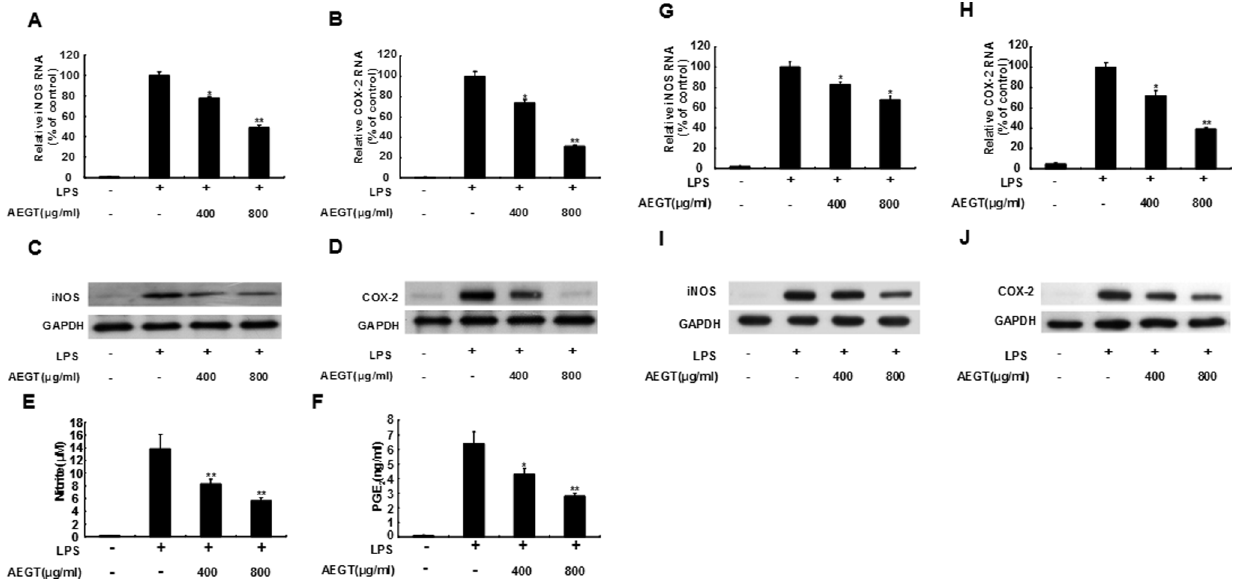
Figure 2. Effect of AEGT on NO/PGE 2 production and iNOS/COX-2 expression in LPS-stimulated RAW 264.7 cells (A–E) and primary rat peritoneal macrophages (G–J). Cells were seeded in a 24-well plate, treated with 400 or 800 m g/ml AEGT for 1 h, and then incubated with 1 m g/ml LPS for 24 h. The cell lysates were collected to determine the RNA (A, B, G and H) and protein (C, D, I and J) levels of iNOS and COX-2 by qRT- PCR with specific primers and western blot analysis with antibodies against iNOS and COX-2, respectively. The efficiency of inhibition was determined as the percent RNA levels relative to those in the cells treated with LPS alone. The supernatant was collected to quantify NO (E) and PGE 2 (F) levels using Griess reagents and an ELISA kit, respectively. Error bars indicate the means 6 SD of three independent experiments. * P , 0.05; ** P ,